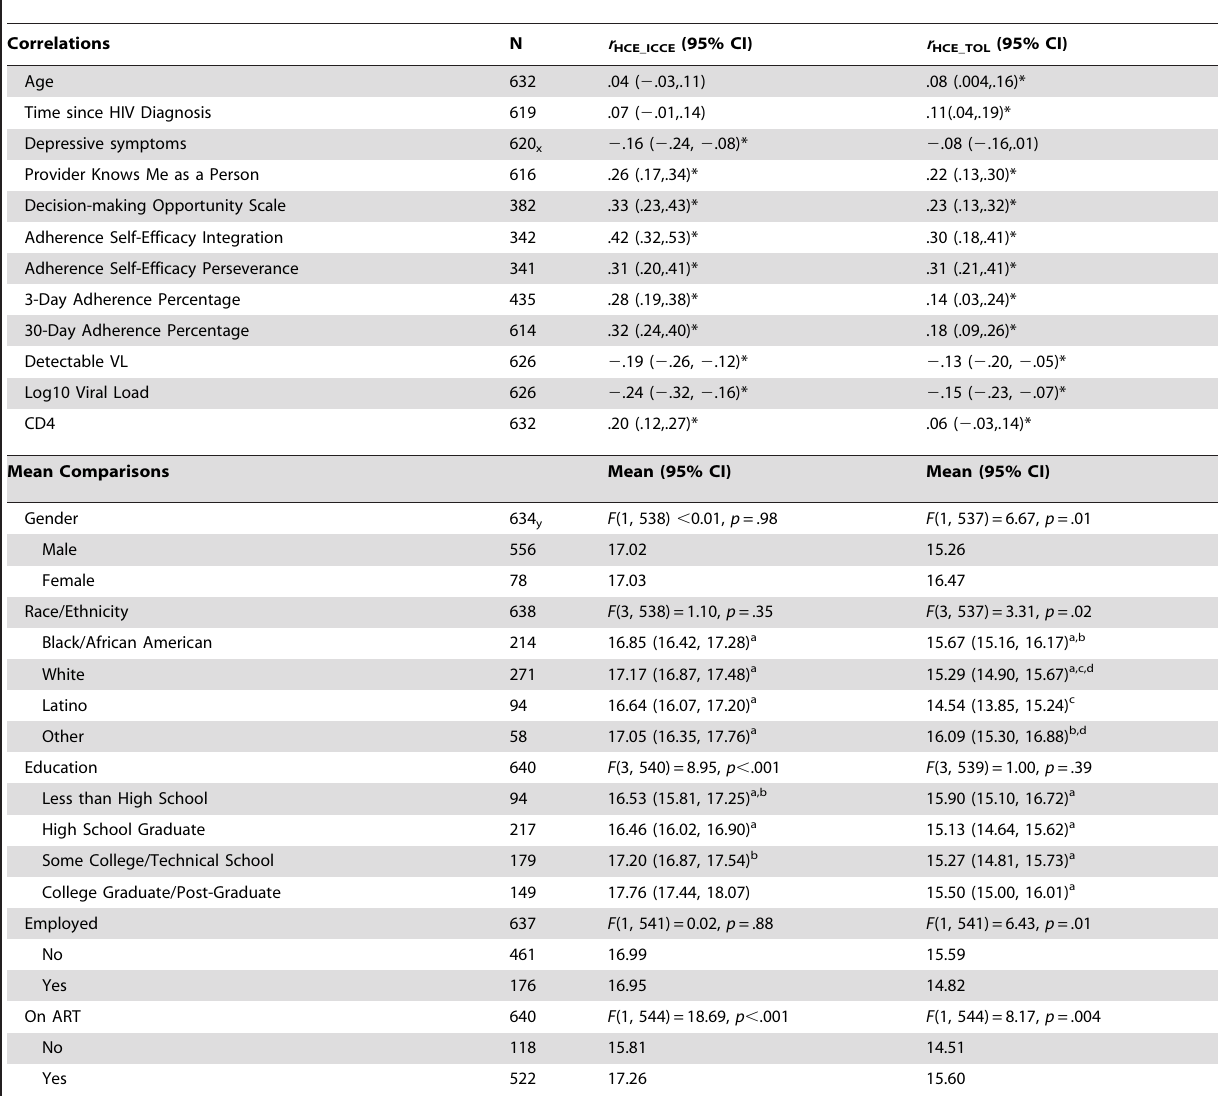
Table 3. Correlations and Mean Comparisons of HCE ICCE and HCE TU Subscales with Patient Clinical and Attitudinal Variables.